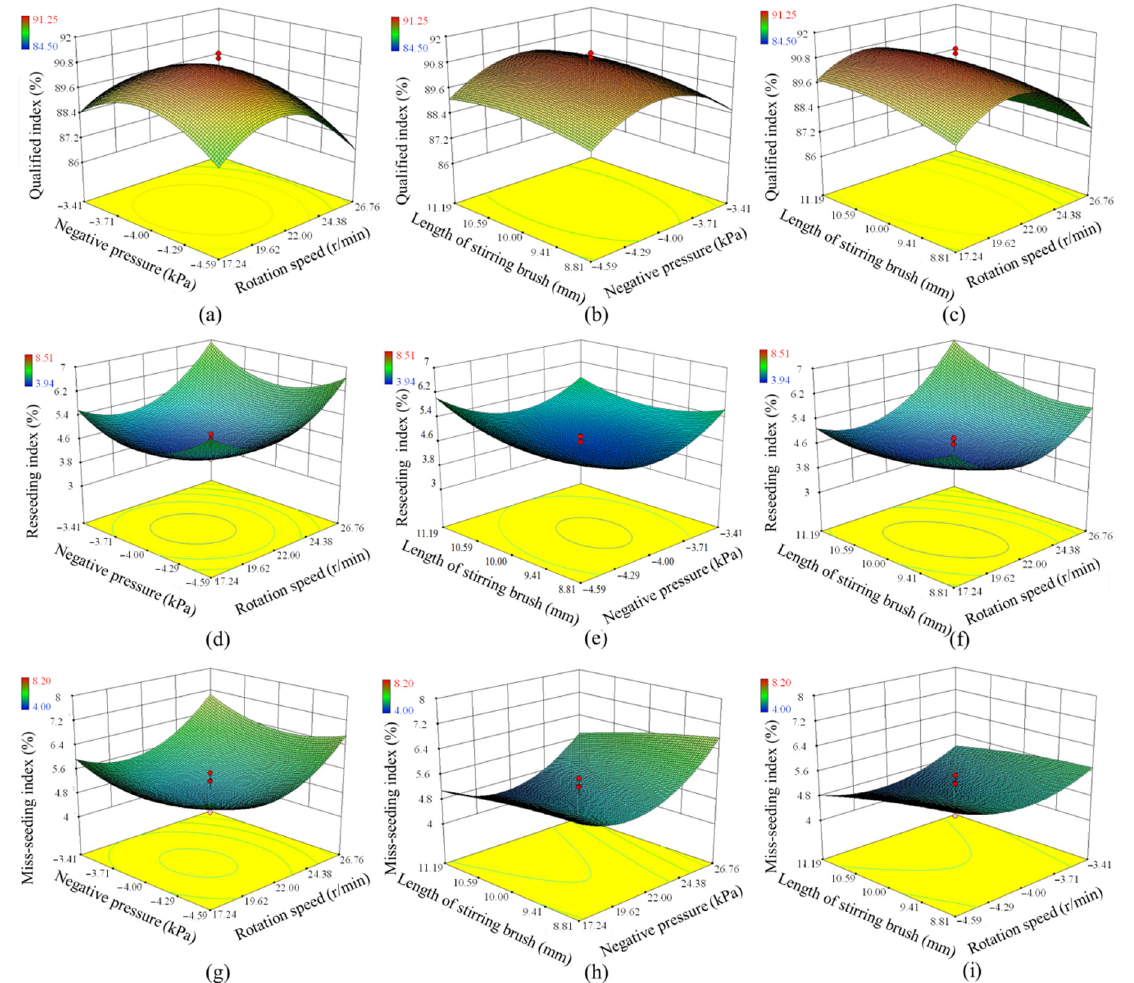
Figure 7. Response surface diagram of influence of various test factors on test indexes: ( a – c ) denotes the influence of negative pressure and rotating speed, negative pressure and length of stirring brush, length of stirring brush and rotating speed on the qualification index respectively; ( d – f ) denotes the effects of negative pressure and rotating speed, negative pressure and stirring brush length, stirring brush length and rotating speed on the reseeding index respectively; ( g – i ) denotes the effects of negative pressure and rotating speed, negative pressure and stirring brush length, stirring brush length and rotating speed on the mis-seeding index.